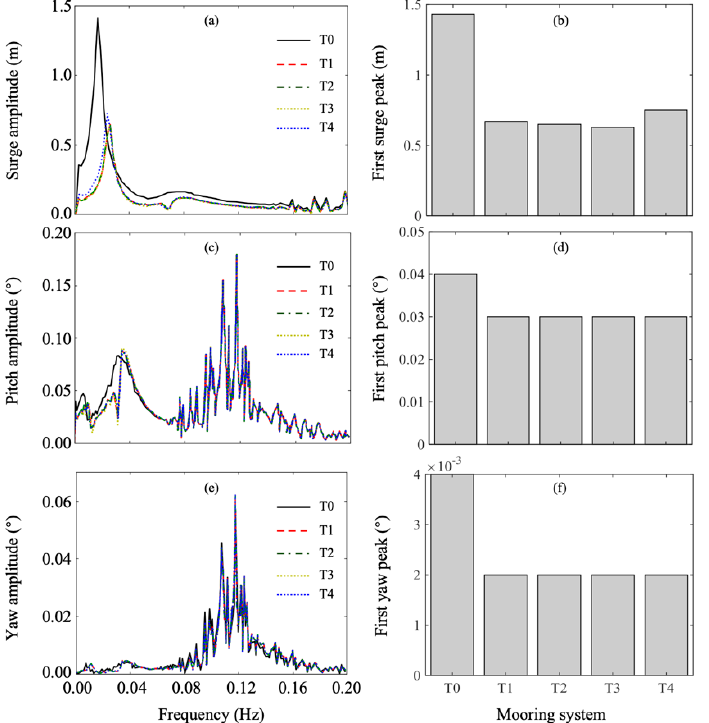
Figure 13. Frequency − amplitude curve and first peak amplitude in C4: ( a ) and ( b ) surge; ( c ) and ( d ) pitch; ( e ) and ( f ) yaw.